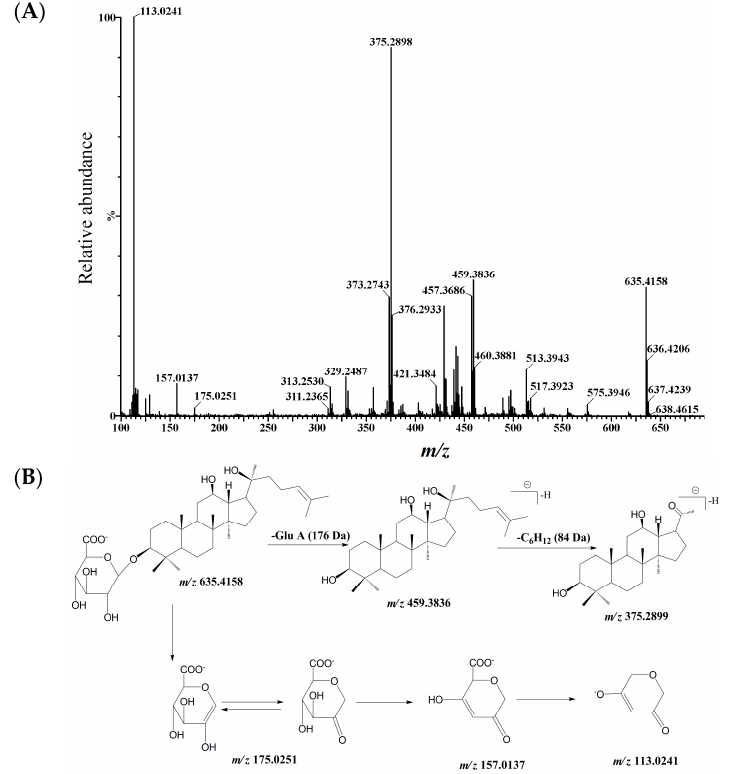
Figure 2. MS 2 spectrum of PPDG ( A ) and its fragmentation pathways ( B ) in negative ion mode obtained from Q/TOF-MS. The MS 2 data were obtained with m / z 635.41 ([M − H] − ) as the precursor ion.